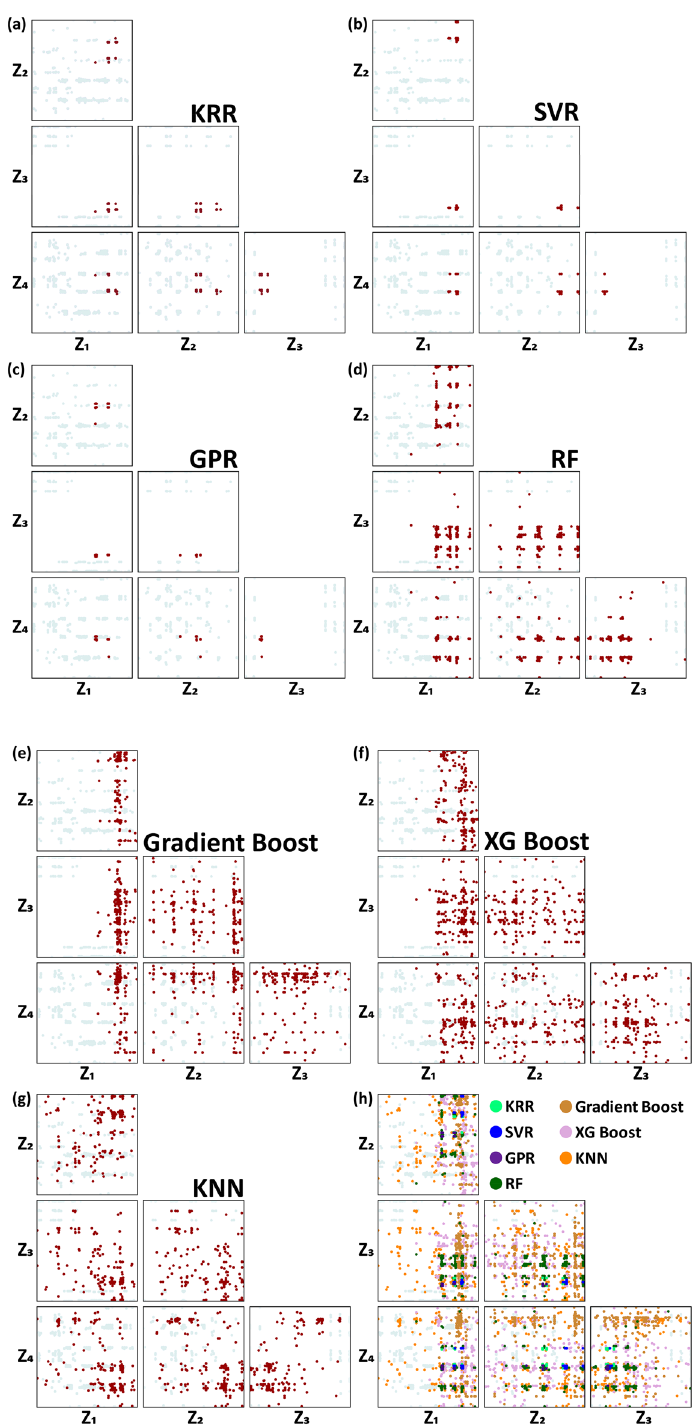
Figure 5. The HRS representation of inverse-predicted solutions for ( a ) KRR, ( b ) SVR, ( c ) GPR, ( d ) RF, ( e ) Gradient Boost, ( f ) XG Boost, and ( g ) KNN regression models, plotted on the HRS represented input feature space, consisting of six pair-wise 2-D scatter plots consisting of z 1 –z 4 , which are considered as an HRS representation unit. The entire dataset was also plotted as a background and the solutions from each ML algorithm are highlighted in dark red color. ( h ) The solutions from all the seven ML algorithms are merged in a single HRS representation unit. Each axis for the six pair-wise 2-D plots designate z 1 –z 4 , and the formulation principle for z 1 –z 4 was presented in Fig.